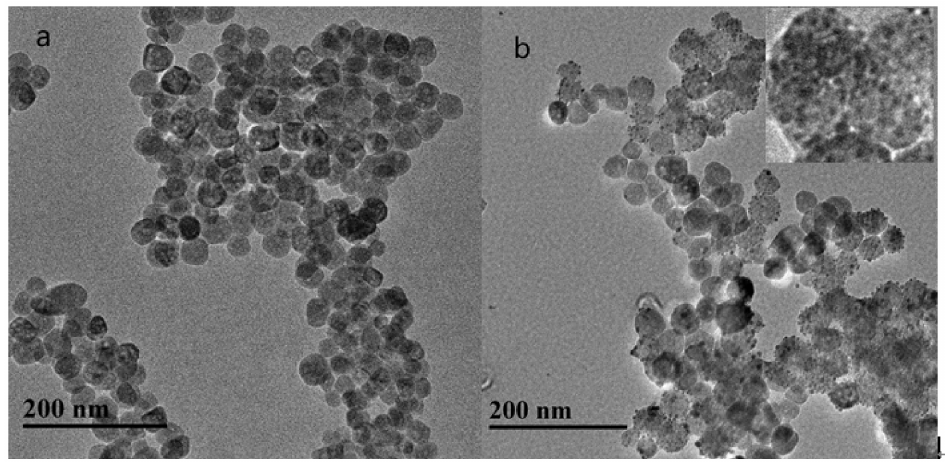
Figure 1. TEM images of ( a ) Fe 3 O 4 and ( b ) Fe 3 O 4 @Au